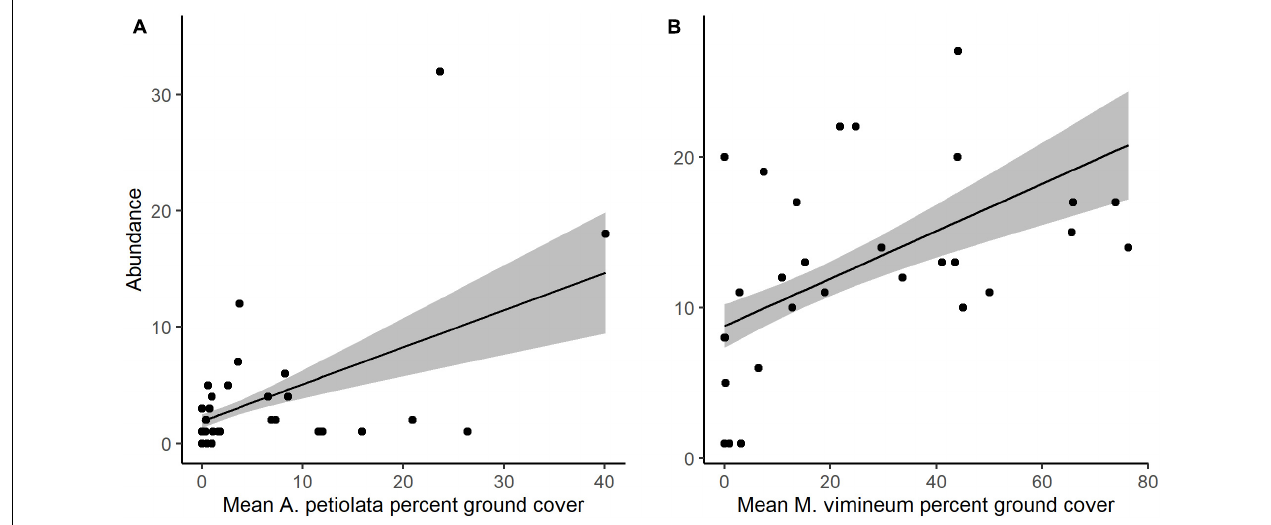
FIGURE 4 | Predicted response of (A) space web weaving spider abundance to ground cover of A. petiolata and (B) hunting spider abundance to ground cover of M. vimineum . Black points represent raw abundance data, lines depict fitted models, and gray shading represents ± 1